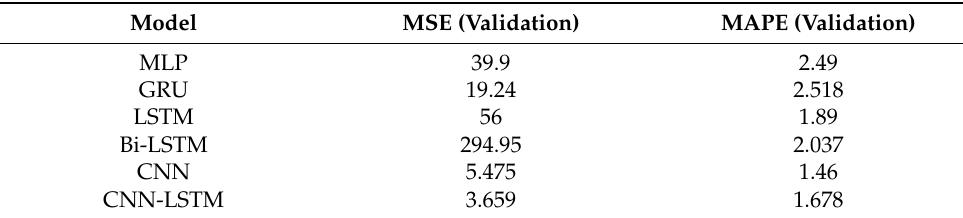
Table 12. The validation results of the models using Tesla data with four input features.